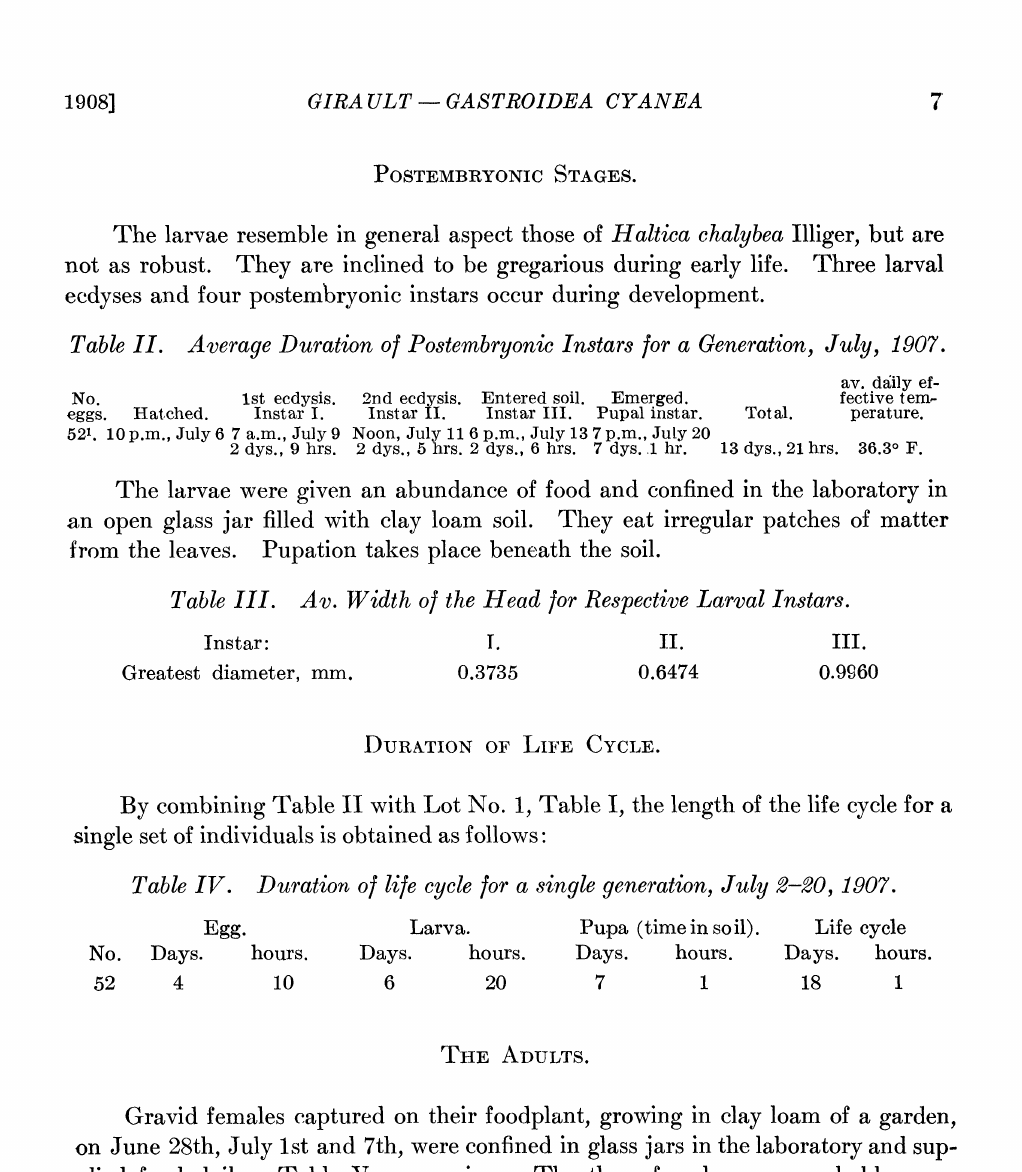
Duration o] li]e cycle ]or a single generation, July 2-ZO, 1907. Egg. Larva. Pupa (time in soil). Life cycle hours. Days. hours. Days. hours. Days. hours. TtE